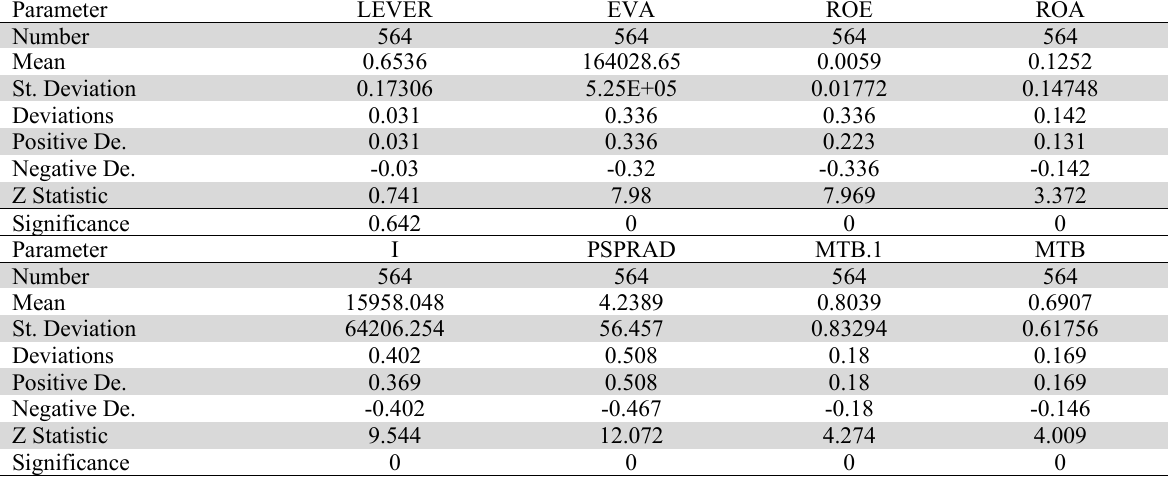
The Summary Results of Kolmogorov Tests